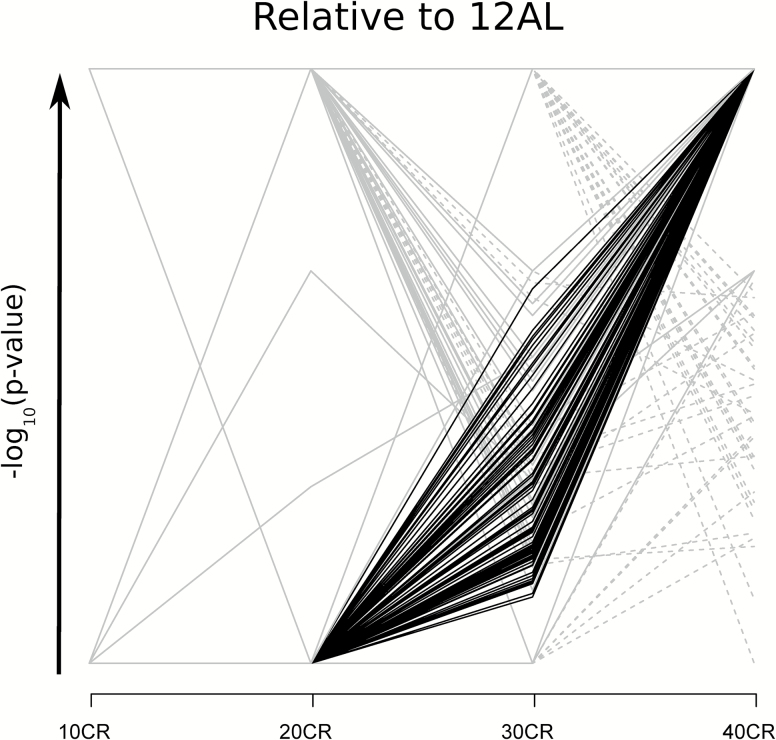
Pathways recruited with increasing CR level identified by Ingenuity Pathway Analysis (IPA, www.qiagen.com/ingenuity). Plot visualizing the increase in significance of pathways with increasing CR level relative to 12AL (n = 287). The Y-axis represents the –log10(p-value) of the pathway, with a maximum value of less than 0.05. A solid line indicates pathways that were significantly altered at 40CR (p < .05) and a dashed line represents pathways that were not significantly altered at 40CR (p > .05) relative to 12AL. The 88 pathways whose significance increased with graded CR by the color black and those who did not with the color grey. 10CR, 20CR, 30CR, and 40CR refer to 10, 20, 30, and 40% restriction.